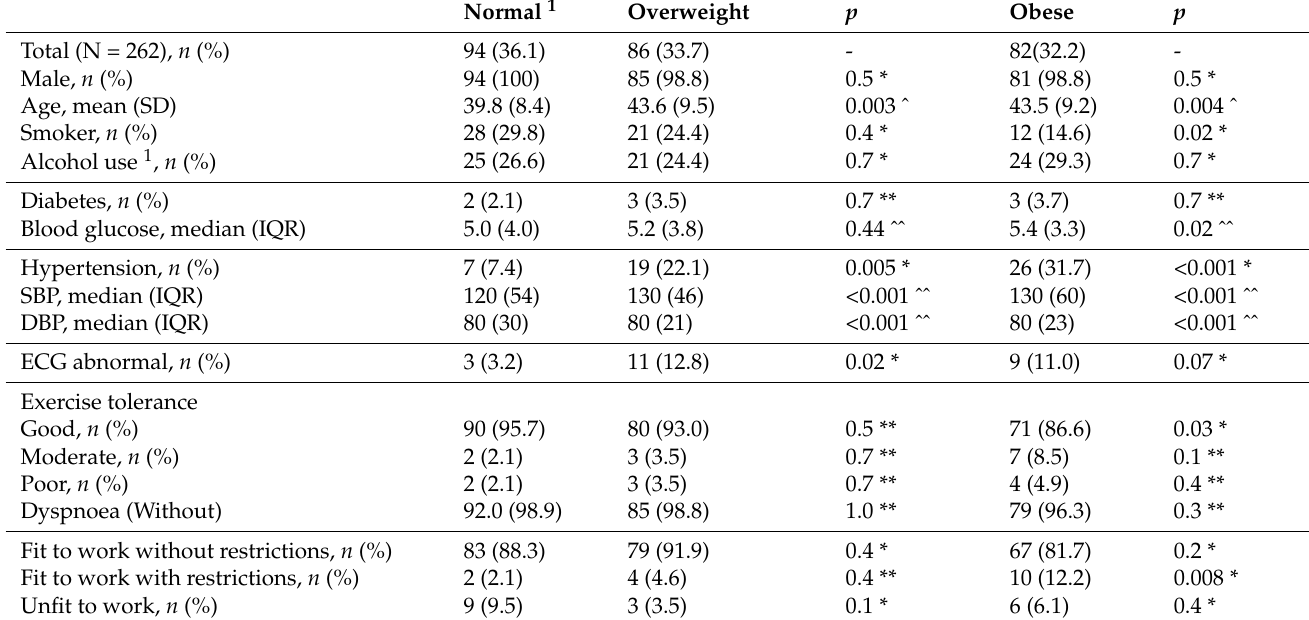
Table 2. Comparison of overweight and obese bus driver demographic and health data versus normal BMI. Normal 1 Overweight p